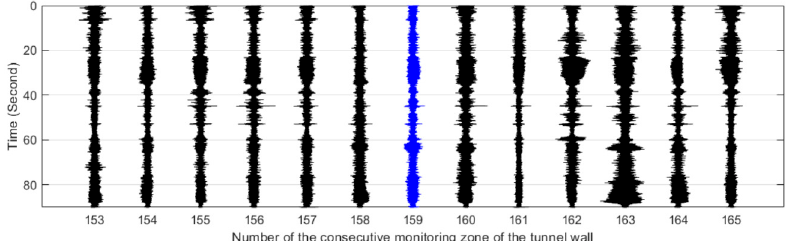
Figure 15. Distributed vibration responses of 13 consecutive monitoring zones under the perturbation of position P5.